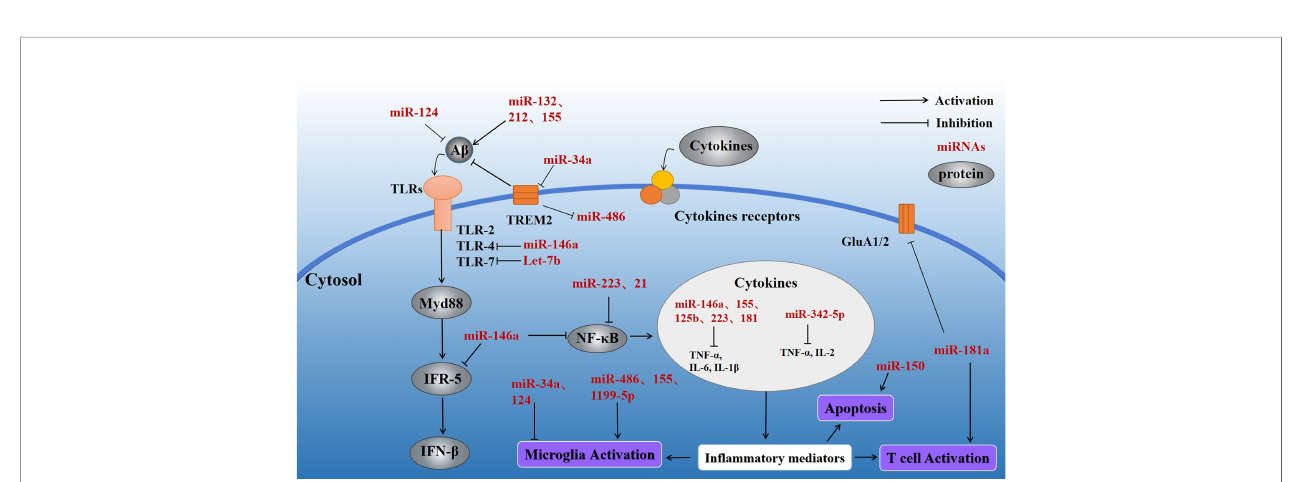
↓ represents down-regulated expression. ↑ represents up-regulated